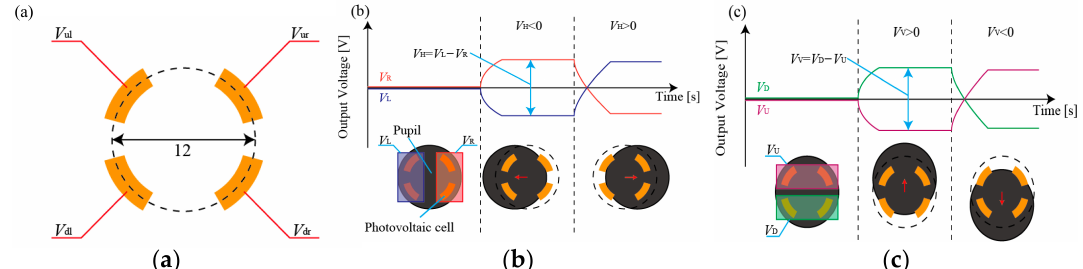
Figure 2. ( a ) Four photovoltaic cells patterned onto the eyeglasses. ( b ) The horizontal position of the pupil can be deduced from the difference between V L and V R , which are the average of the two left cells ( V ul and V dl ) and the two right cells ( V ur and V dr ). ( c ) The vertical position of the pupil can be deduced from the difference between V U and V D , which are the averages of the two upper cells ( V ul and V ur ) and the two bottom cells ( V dl and V dr ).